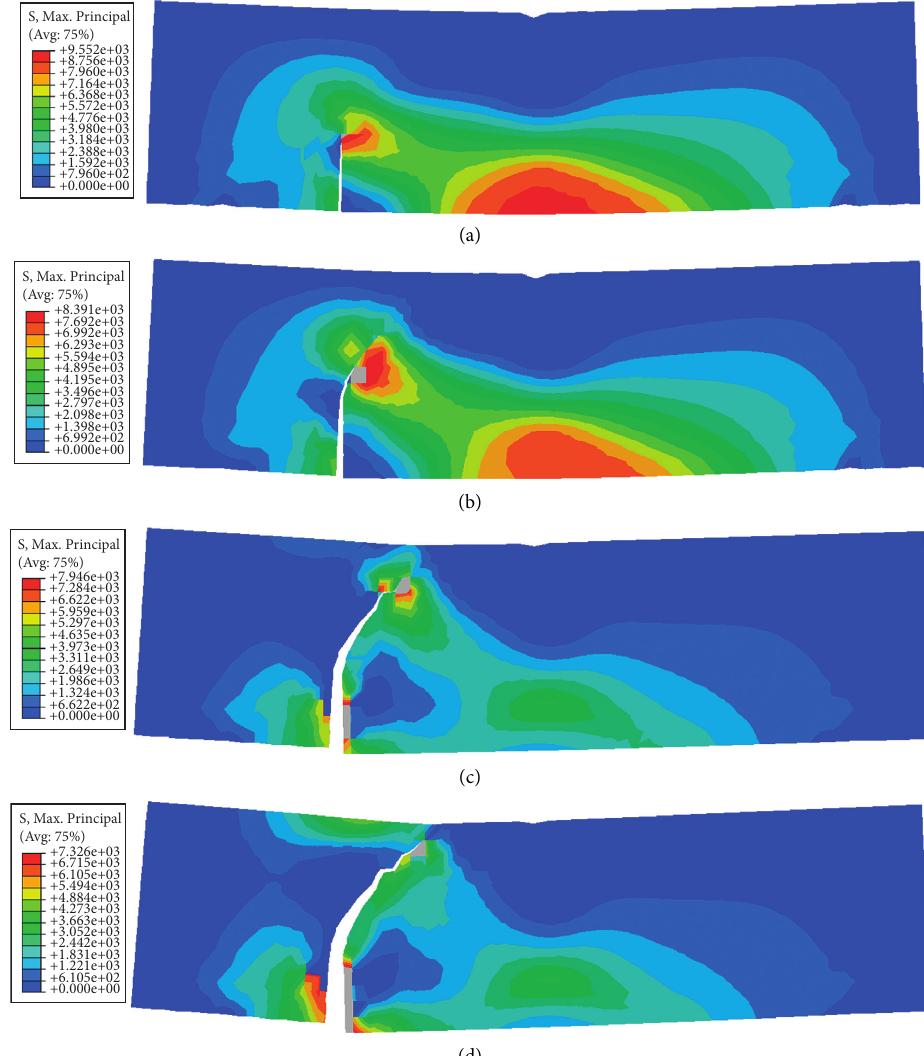
Figure 17: The MPSN of the crack propagation process using XFEM. (a) Initial stage; (b) early stage; (c) mid-late stage; and (d) complete crack stage of crack propagation process.